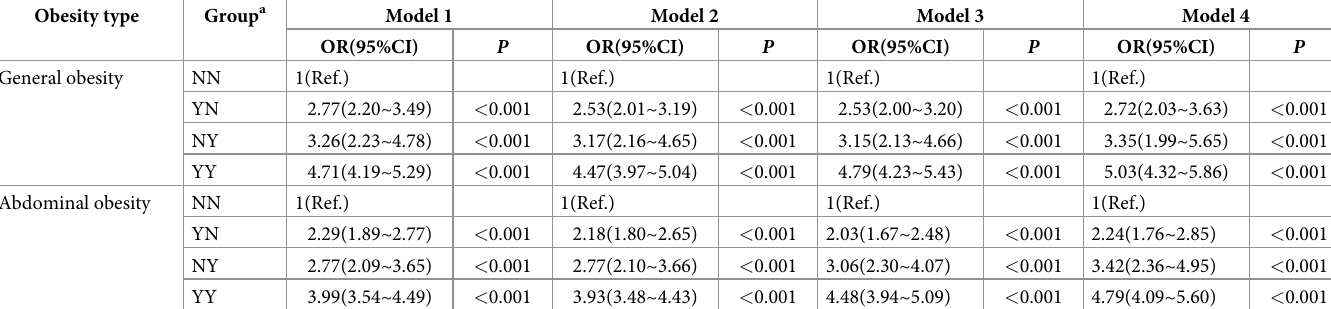
0.21~0.88 kg/m 2 of BMI (only 0.86%~3.59% of the baseline BMI, baseline BMI = 24.49 kg/m 2 , Table 3. Association between risk of high blood pressure and different general or abdominal obesity status